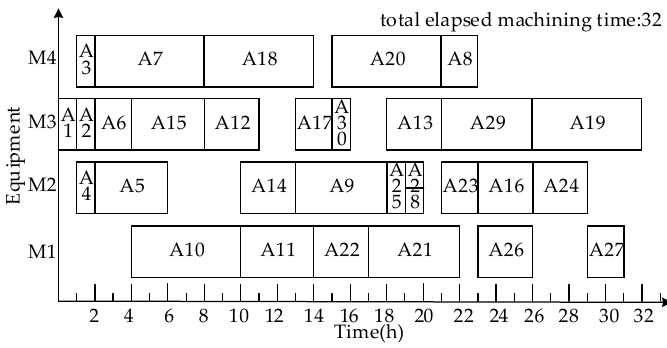
Figure 7. Gantt chart of scheduling A using TISA.